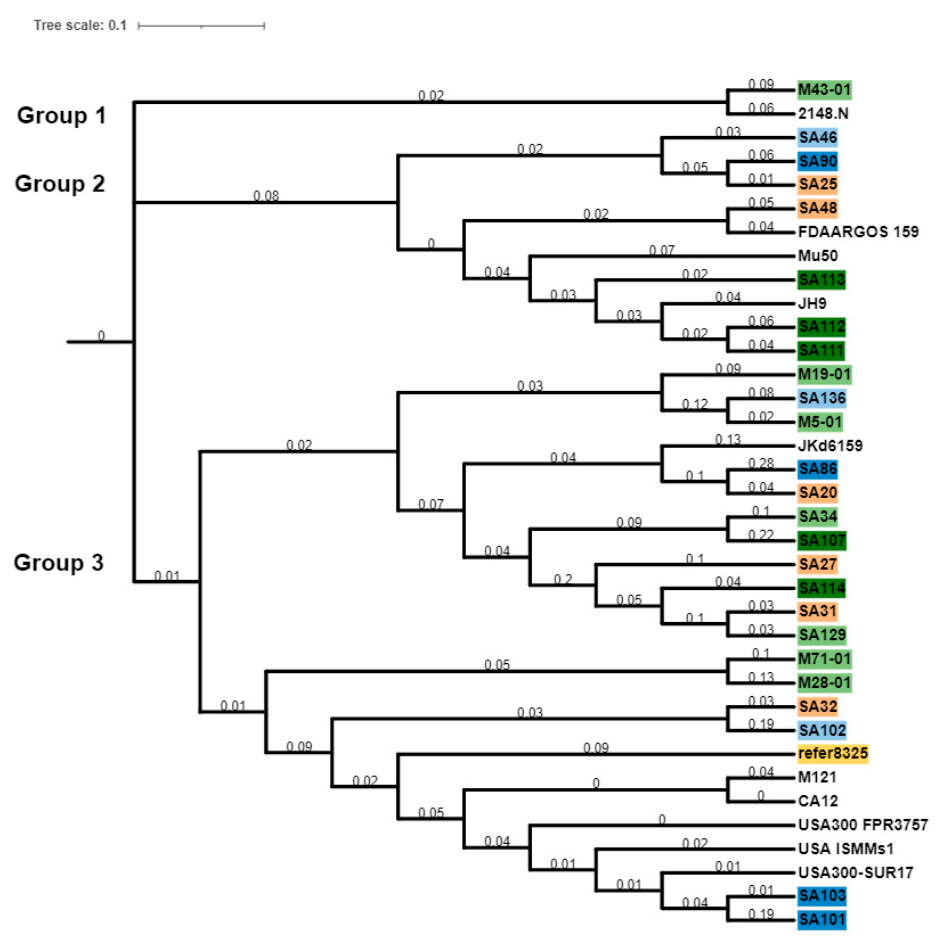
Figure 7. Pan genome phylogeny of S. aureus isolates. S. aureus strain NCTC 8325 was used as a reference strain (yellow color). Isolates in shades of green are conjunctivitis strains; dark green indicates conjunctivitis strains from USA, and light green conjunctivitis strains from Australia. Shades of blue indicate MK strains; dark blue represents MK strains from USA and light blue represents MK strains from Australia. Isolates in peach color are strains from niCIE and those with no color are non-ocular isolates. The tree was constructed using online webtool itol (interactive tree of life, https://itol.embl.de/, (accessed on 4 April 2022). The tree scale indicates differences between the isolates and branch length indicates the number of changes that have occurred in that branch.